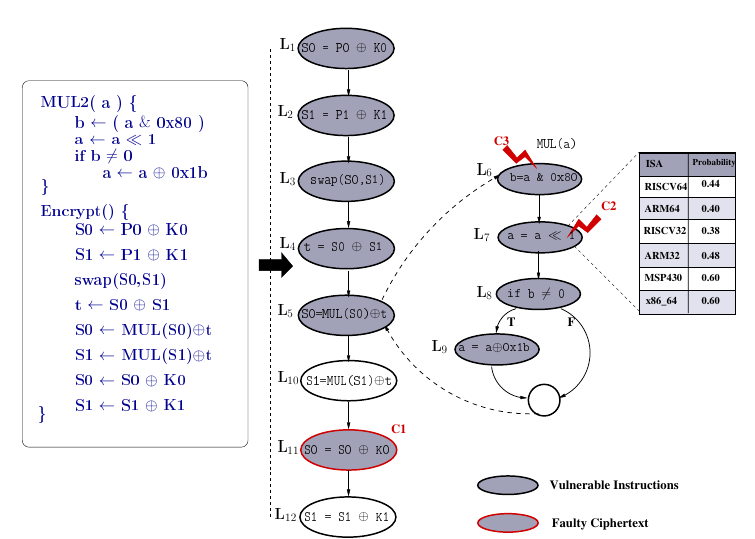
Figure 2: The pseudo-code of a toy cipher, where (P0,P1) and (K0,K1) are pairs of plaintext and secret key bytes, respectively. The output of the cipher is the ciphertext bytes (S0, S1) . The figure also shows the Control Flow Graph (CFG) for the code with vulnerable nodes with respect to K0 highlighted. The vertices in the CFG represent the operations of the cipher, and the edges represent the program control flow. A fault in vulnerable instructions can potentially alter its output. The probability that this happens intricately depends on the underlying